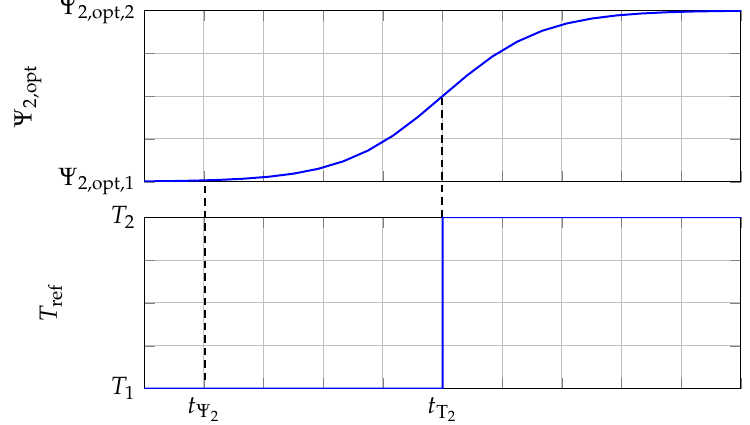
Figure 5. Torque profile T ref and corresponding optimal rotor flux Ψ